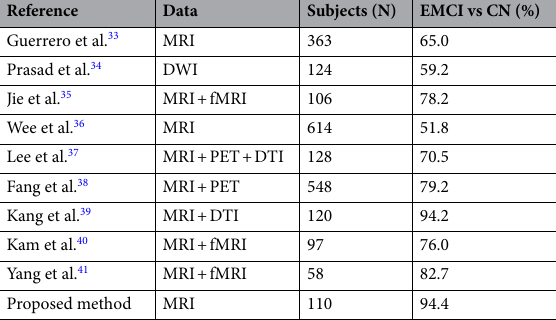
Table 2. Summary of the studies using ADNI dataset for classification of patients with early mild cognitive impairment (EMCI) and cognitively normal (CN) participants. DTI diffusion tensor imaging, DWI diffusion- weighted imaging, PET positron emission